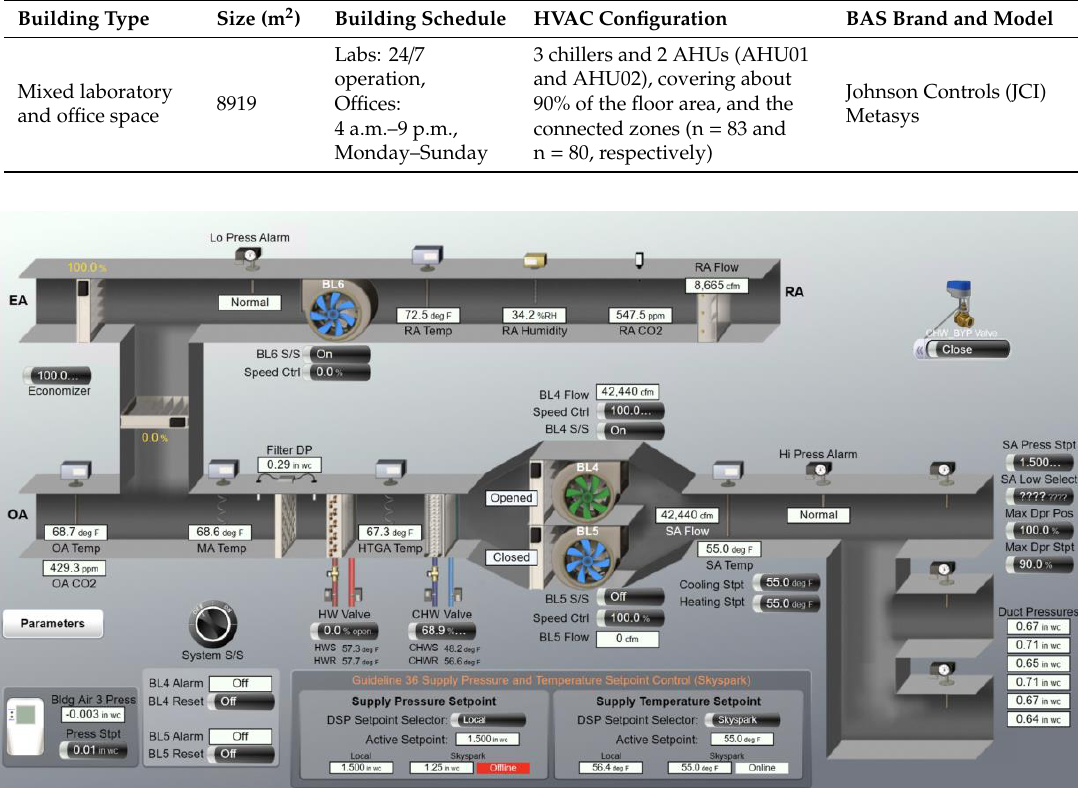
Figure 5. BAS graphics for the AHU02 at the test site. AHU01 has a similar structure.